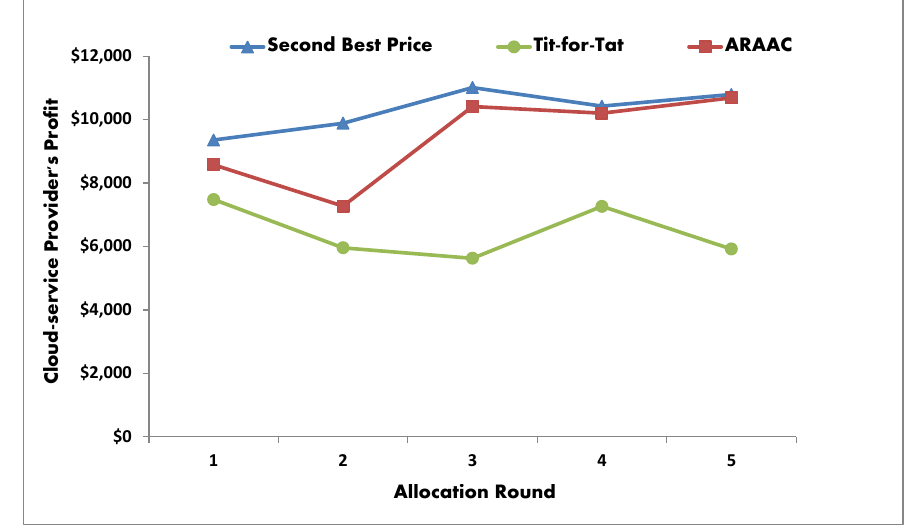
Figure 2. Profit gains of the simulated allocation